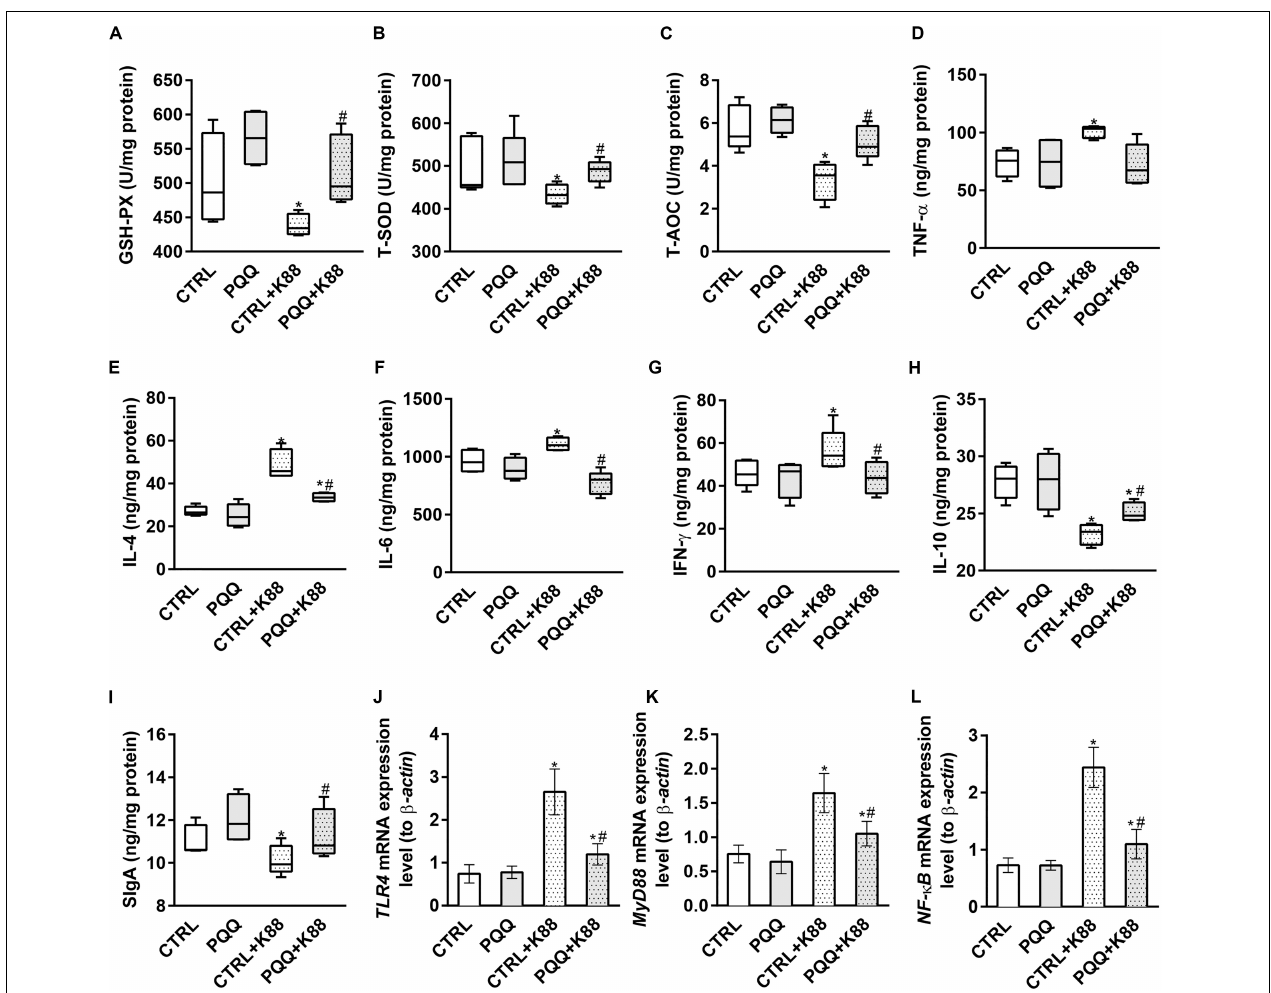
FIGURE 2 | Effects of PQQ supplementation on mucosal cytokine expression in the jejunum after ETEC K88 challenge in weaned pigs. (A–C) The activities of antioxidant enzymes in the mucosa. (D–I) The levels of immune and inflammatory cytokines in the jejunum. (J–L) Data were obtained by real-time PCR; β -actin was the housekeeping gene. CTRL, piglets fed the basal diet; PQQ, piglets fed the basal diet supplemented with PQQ; CTRL + K88, piglets fed the basal diet and challenged with ETEC K88; PQQ + K88, piglets fed the basal diet supplemented with PQQ and challenged with ETEC K88. * denotes a significant difference ( P < 0.05) from the CTRL group. # denotes a significant difference ( P < 0.05) from the CTRL + K88 group; n =